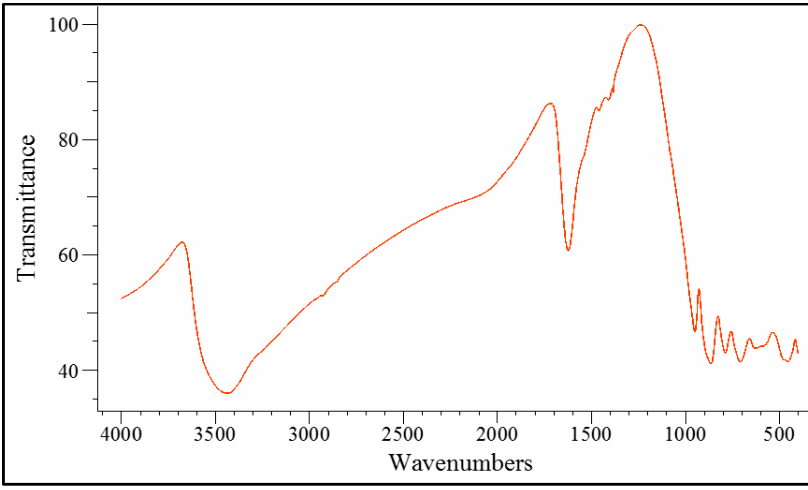
Figure 4. Infrared spectrum of CsNa-1